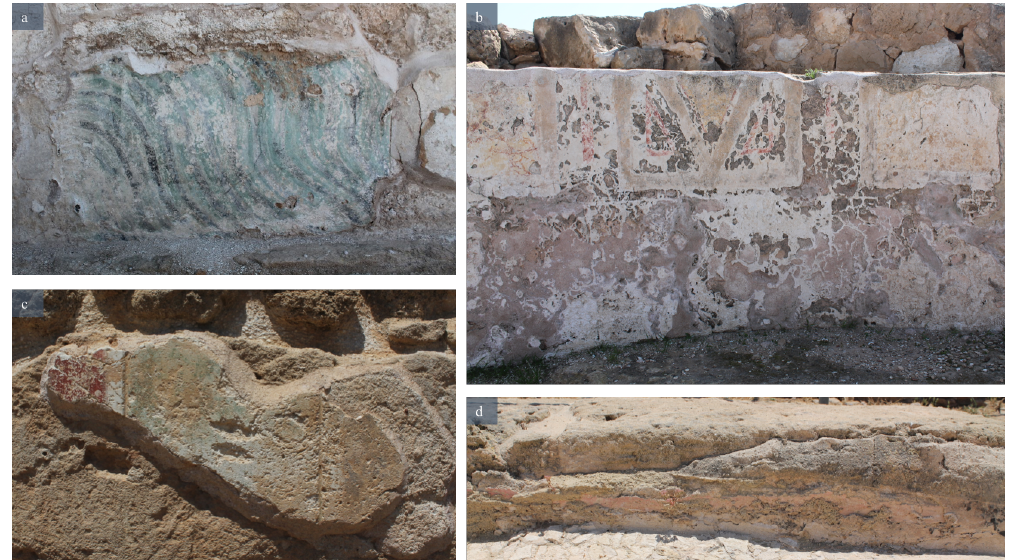
Figure 5. Examples of domestic in situ wall paintings in the Paphos Archaeological Park: ( a , b ) Imitation marble revetment and geometric designs in the Villa of Theseus; ( c , d ) the Hellenistic